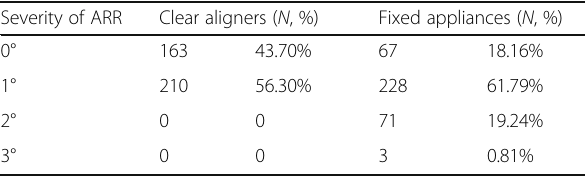
Table 5 Classification of overall severity of apical root resorption (ARR) in the two groups Severity of ARR Clear aligners ( N , %) Fixed appliances ( N ,